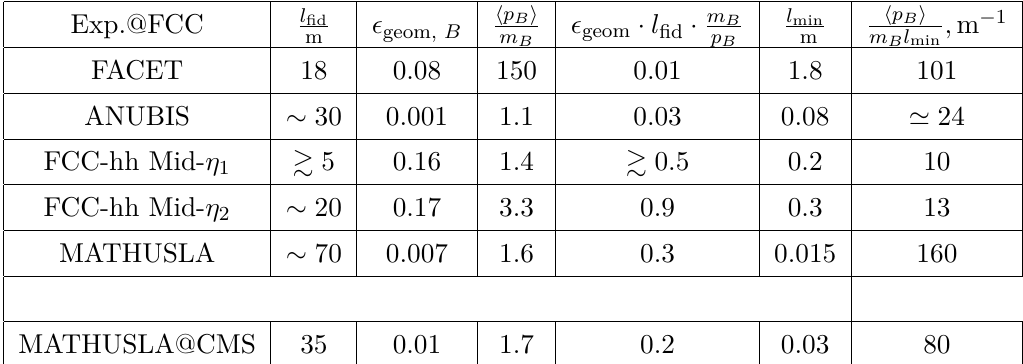
Table 2 . Values of the experiment-dependent parameters in eq. (4.1): the average length of the decay volume l ; the geometric acceptance (cid:15) — the fraction of B mesons flying in the direction fid geom of detector; the mean momentum of B mesons p ; the product of these parameters determining B the number of events in the regime of small lifetimes cτγ (cid:29) l + l (larger is better); the min fid characteristic minimal distance from the collision point to the beginning of the decay volume l ; min the ratio h p determining the sensitiivity in the regime of large lifetimes cτγ . l + l B i /l min min fid (larger is